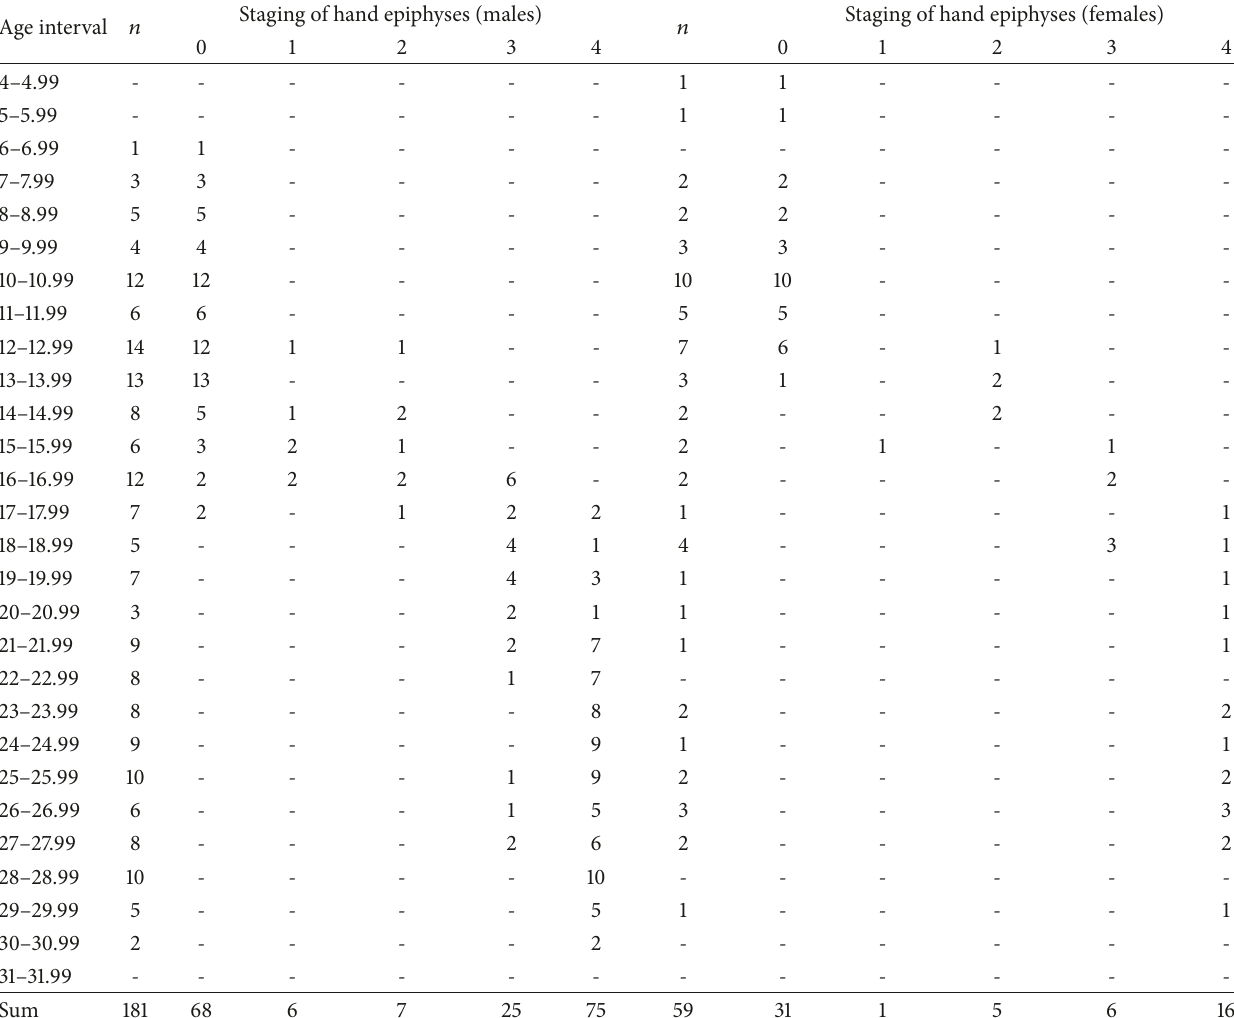
Table 2: Numbers of images at each stage of epiphyseal union of the hand joints bones.